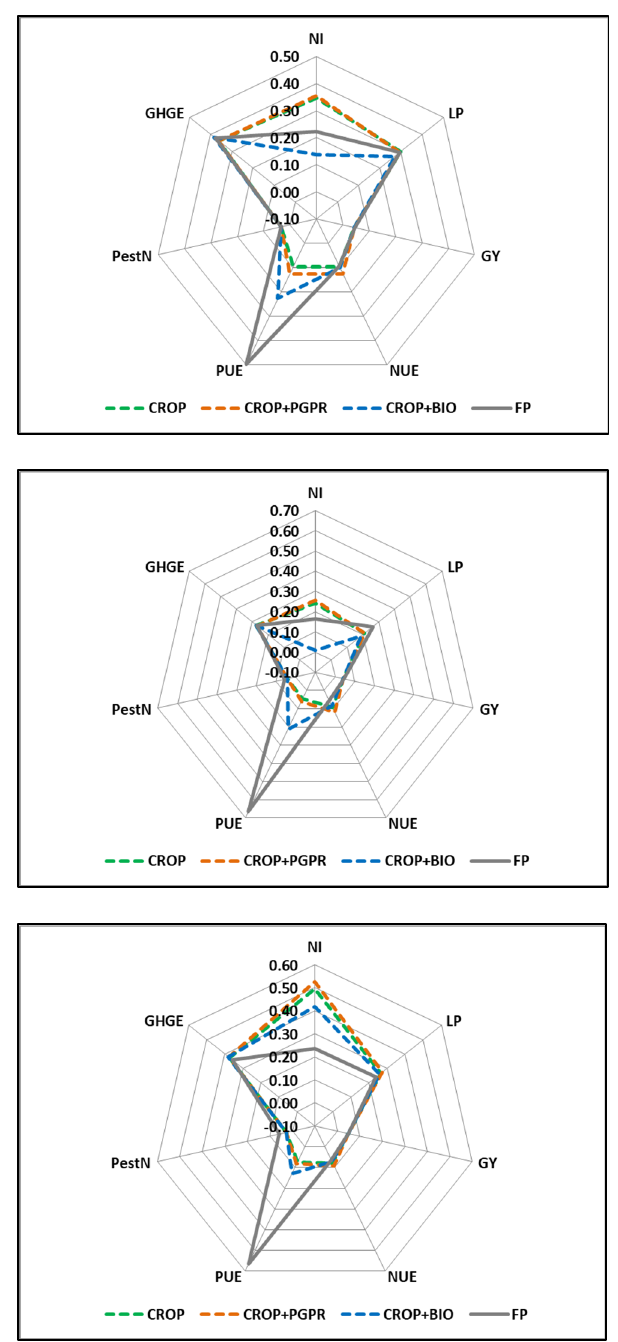
Figure 1. Trade ‐ off comparison among the different performance indicators during: (upper) 2016 WS, (middle) 2016–17 DS and (lower) 2017 WS across four field trial treatments in the Central Plains Thailand. Symbols and units: NI = net income (USD ha – 1 ); LP = labor productivity (kg day – 1 ); GY = grain yield (t ha – 1 ); NUE = nitrogen ‐ use efficiency (grain kg N kg – 1 ); PUE = phosphorus ‐ use efficiency (grain kg P kg – 1 ); PestN = no. of pesticide applications; and GHGE = greenhouse gas emission (kg CO 2 equivalent ha – 1 ).